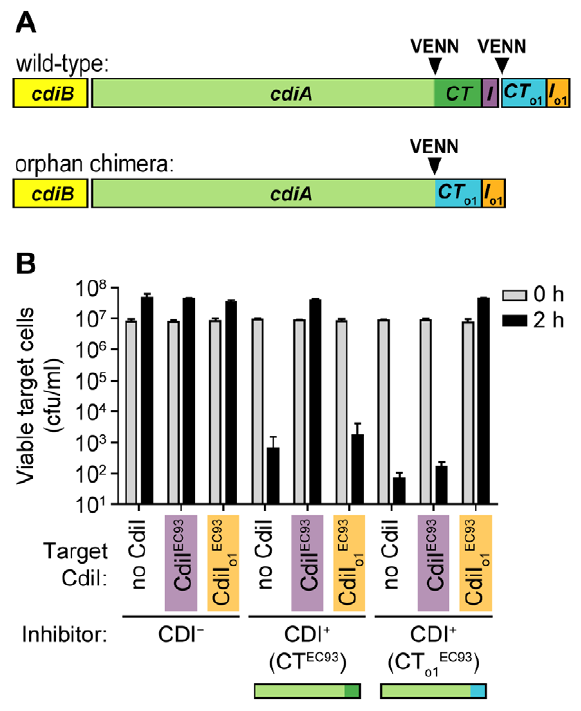
Figure 6. The EC93 orphan cdiA-CT/cdiI module is functional in contact-dependent growth inhibition (CDI). A) The wild-type EC93 and orphan chimera CDI systems are shown schematically. The cdiA-CT EC93 /cdiI EC93 region was deleted and orphan module fused onto the cdiA EC93 gene at the VENN encoding sequence. B) Growth competitions. CDI + inhibitor cells were co-cultured with target cells expressing either CdiI EC93 or orphan CdiI o1EC93 immunity proteins. Viable target cells were quantified by plating on selective media to determine the number of colony forming units (cfu) per milliliter.